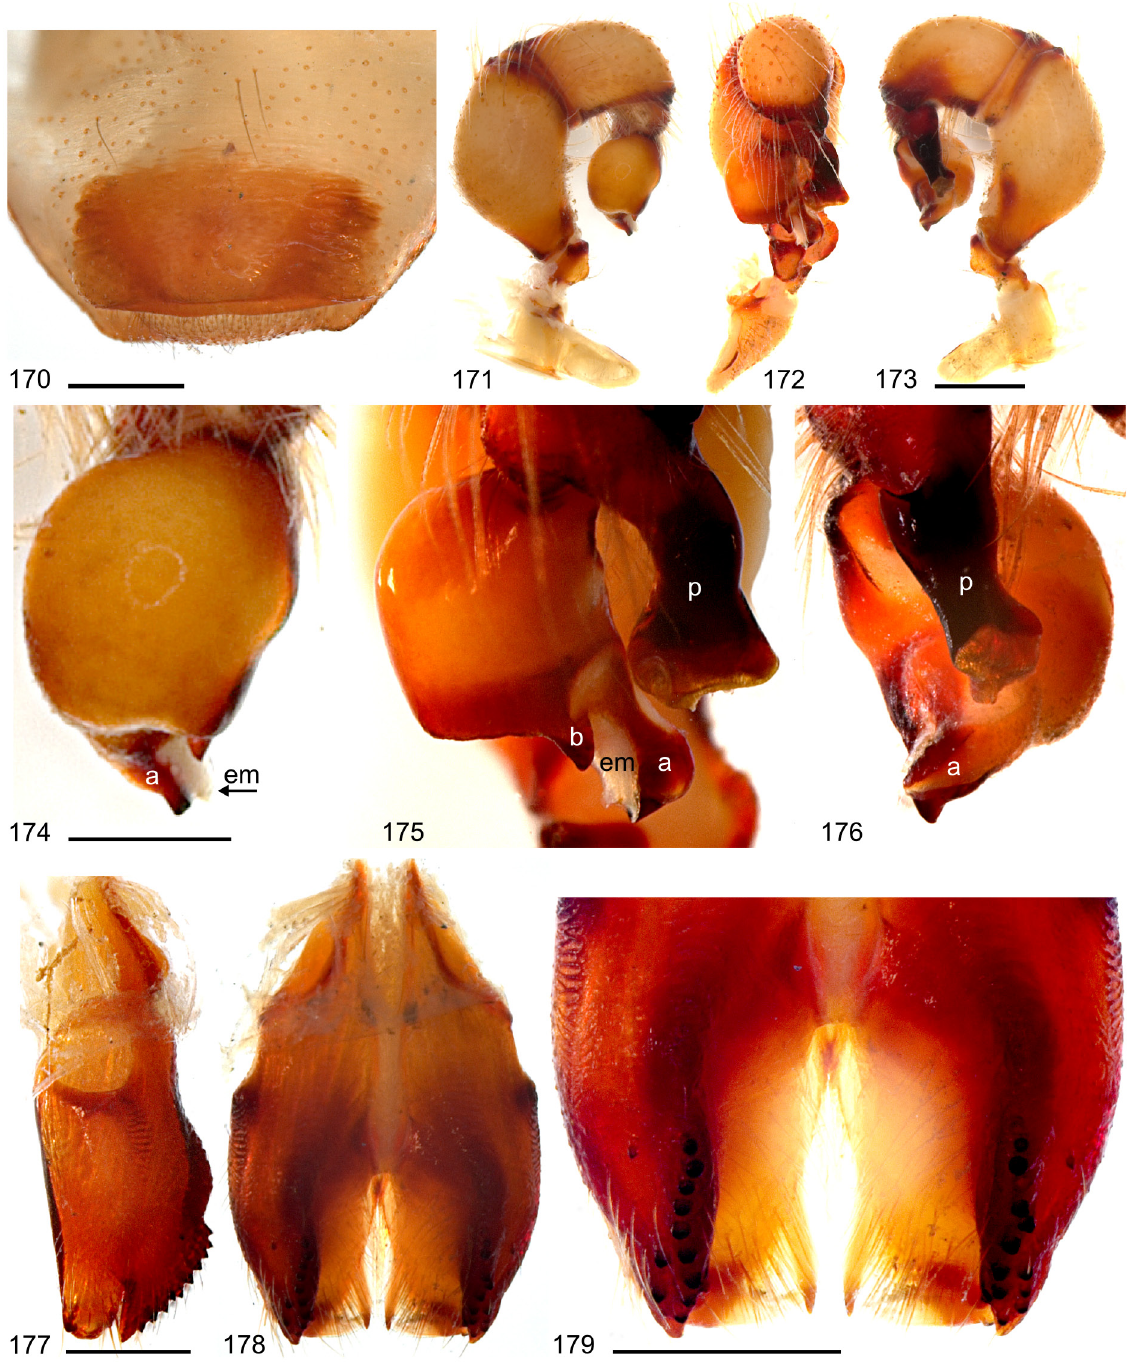
Figs 170–179. 170 . Artema sp. a from Oman Jebal Akhdar, E of Al Hamra, Al Ghubrat (NHMW), epigynum, ventral view. 171–179 . Artema sp. b from Algeria, El Goléa (NHMW). 171–173 . Male left pedipalp: prolateral, dorsal, and retrolateral views. 174–176 . Male left bulb and procursus: prolateral, dorsal, and retrolateral views. 177–179 . Male chelicerae: lateral and frontal views. Scale lines: 170, 174–179 = 0.5 mm; 171–173 =